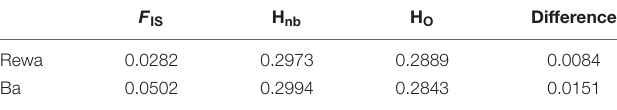
TABLE 2 | Measures of diversity for each population sample, including the inbreeding coefficient F IS , adjusted expected heterozygosity Hnb, observed heterozygosity HO, and the difference between Hnb and Ho. F